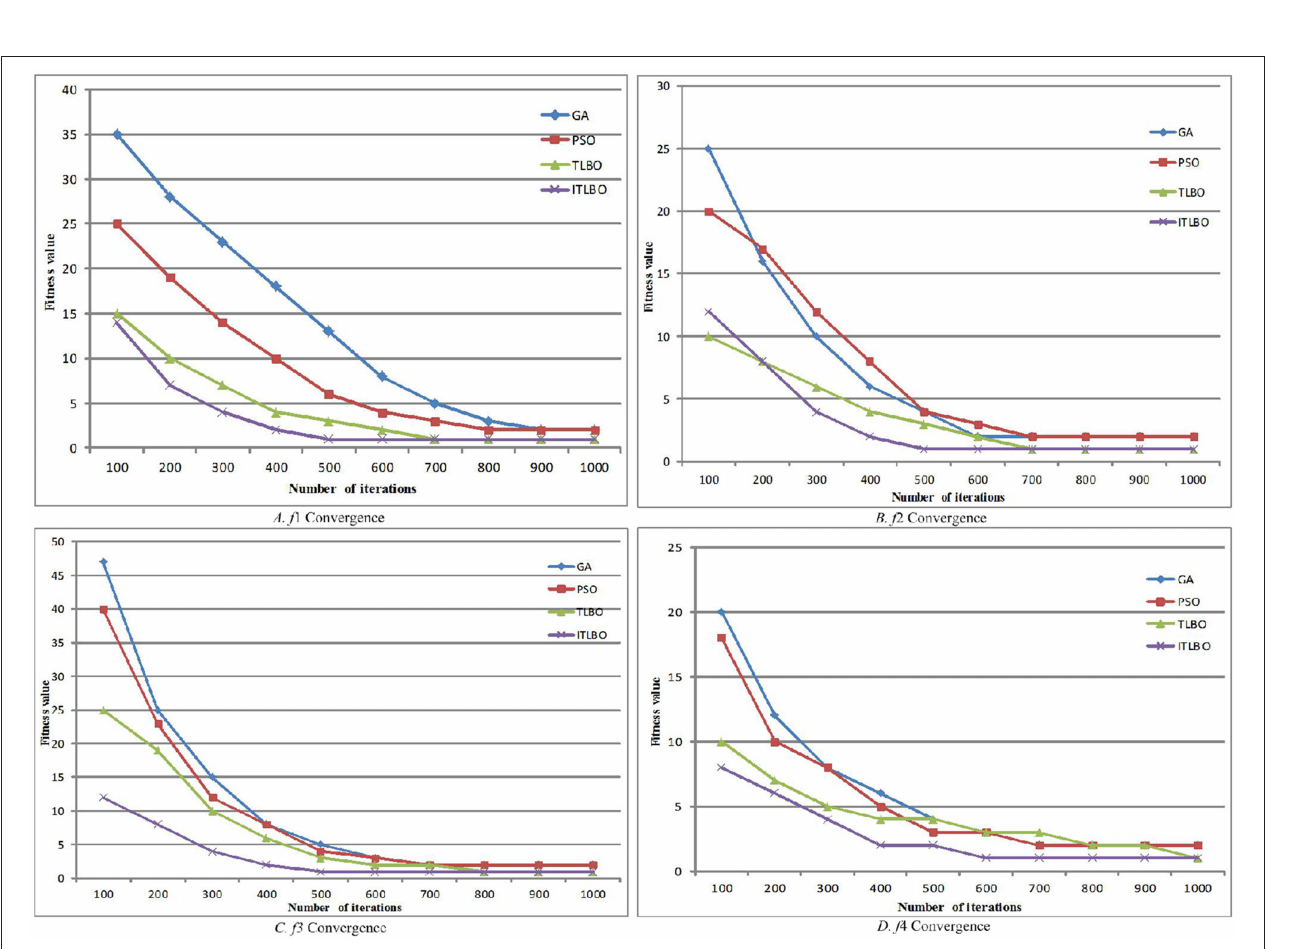
Frontiers in Physics |